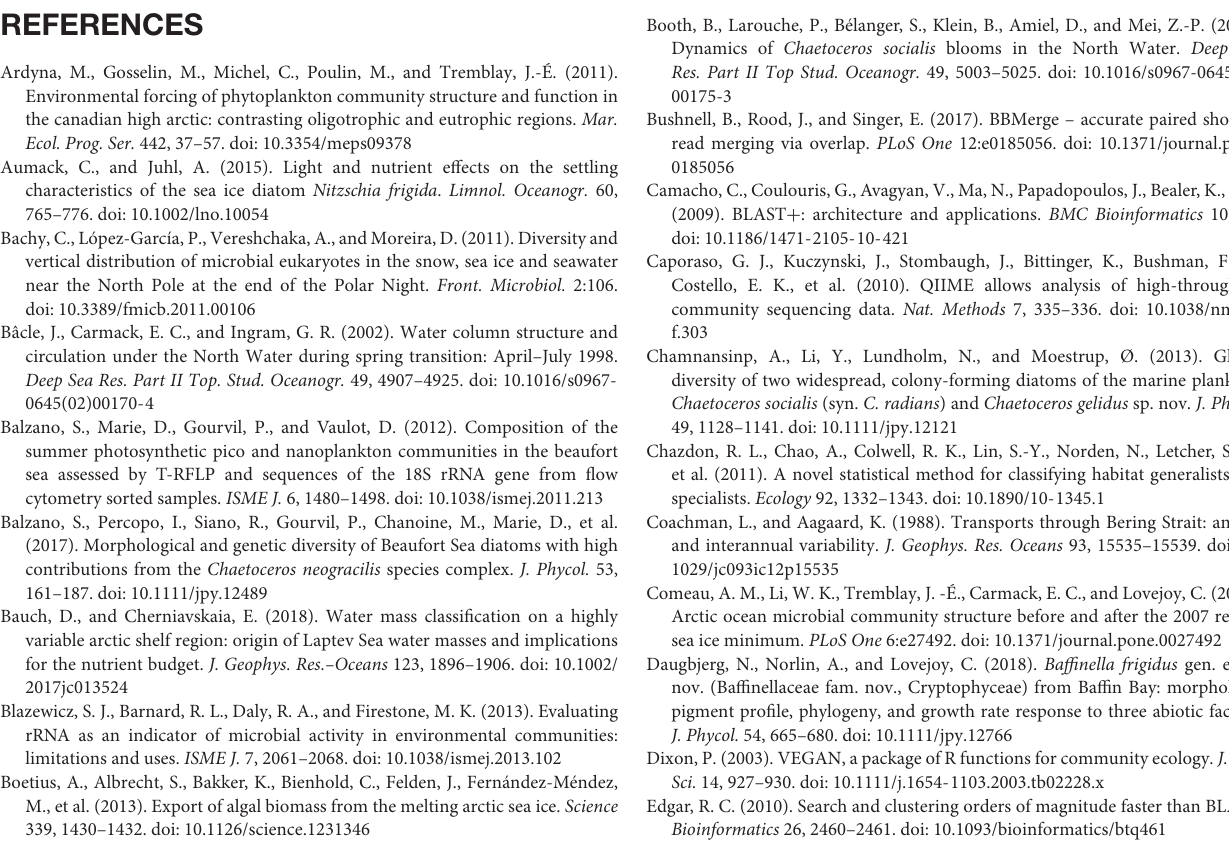
FIGURE S3 | Decision tree applied to each OTUs present in the Ken1 station to categorize them into each of the eight categories used in source tracking from the rarified data set (see the text). Below each category is the number of sequences and OTUs in the category. FIGURE S4 | Depth profiles of the rDNA and rRNA fractions showing the relative proportion of sequences belonging to the categories defined from station Kennedy 1 following Supplementary Figure S3 . FIGURE S5 | Taxonomic contribution to the categories displayed in Supplementary Figure S4 , for the rDNA and rRNA fraction. (a) “Ken1 All Depths rDNA” and “Ken1 All Depths rDNA and rRNA” categories. (b) “Ken1 aphotic rDNA” and “Ken1 aphotic rDNA and rRNA” categories. (c) “Ken1 photic rDNA” and